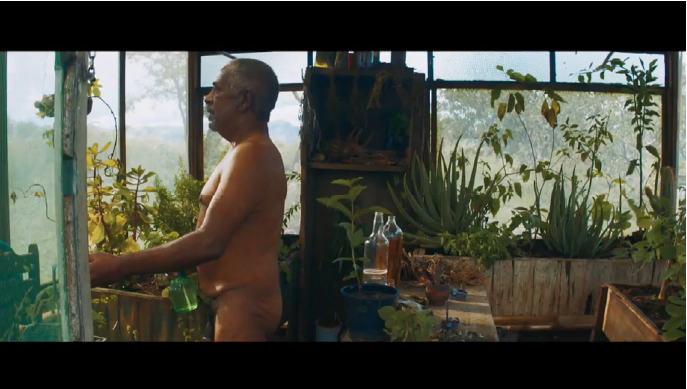
Figure 1. Film still, Bacurau .